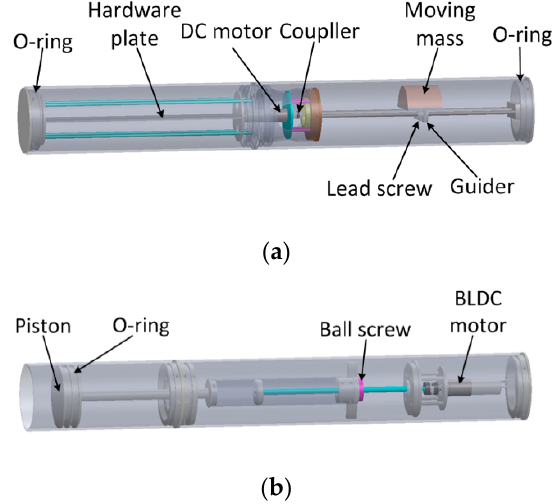
Figure 2. Mass-shifter ( a ) and buoyancy engine ( b ) design. A DC motor is used in the mass-shifter, and a Brushless DC motor is installed in the buoyancy engine.